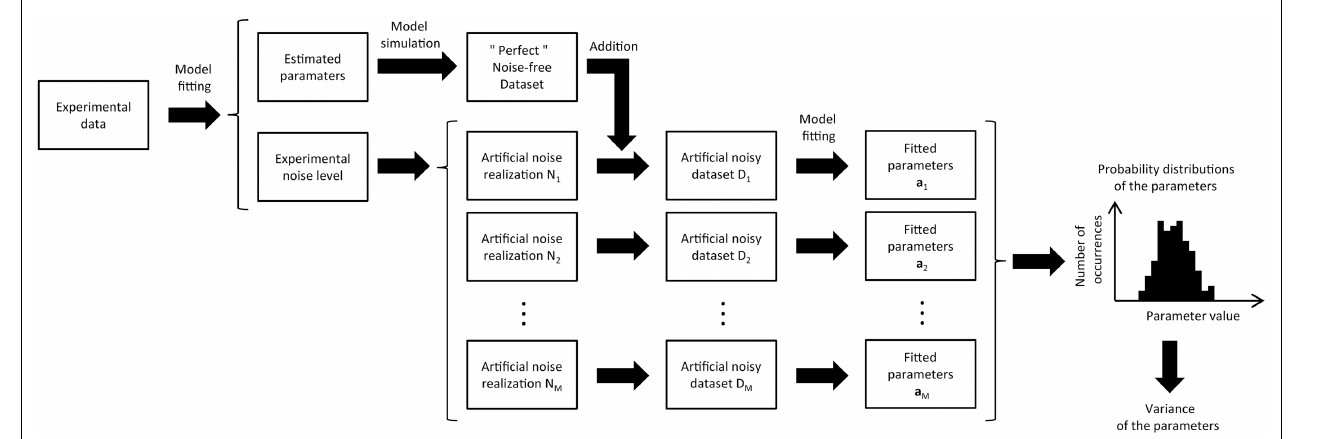
turnover curves obtained from the best fit. For each turnover curve, the artificial noise realizations are generated with the same noise level as in the corresponding experimental curves. Finally, the metabolic model is successively fitted to all the synthetic datasets, resulting in a distribution of fitted values for every free parameter of the model.This distribution characterizes the precision of each adjusted parameter, taking directly into account the experimental noise level.